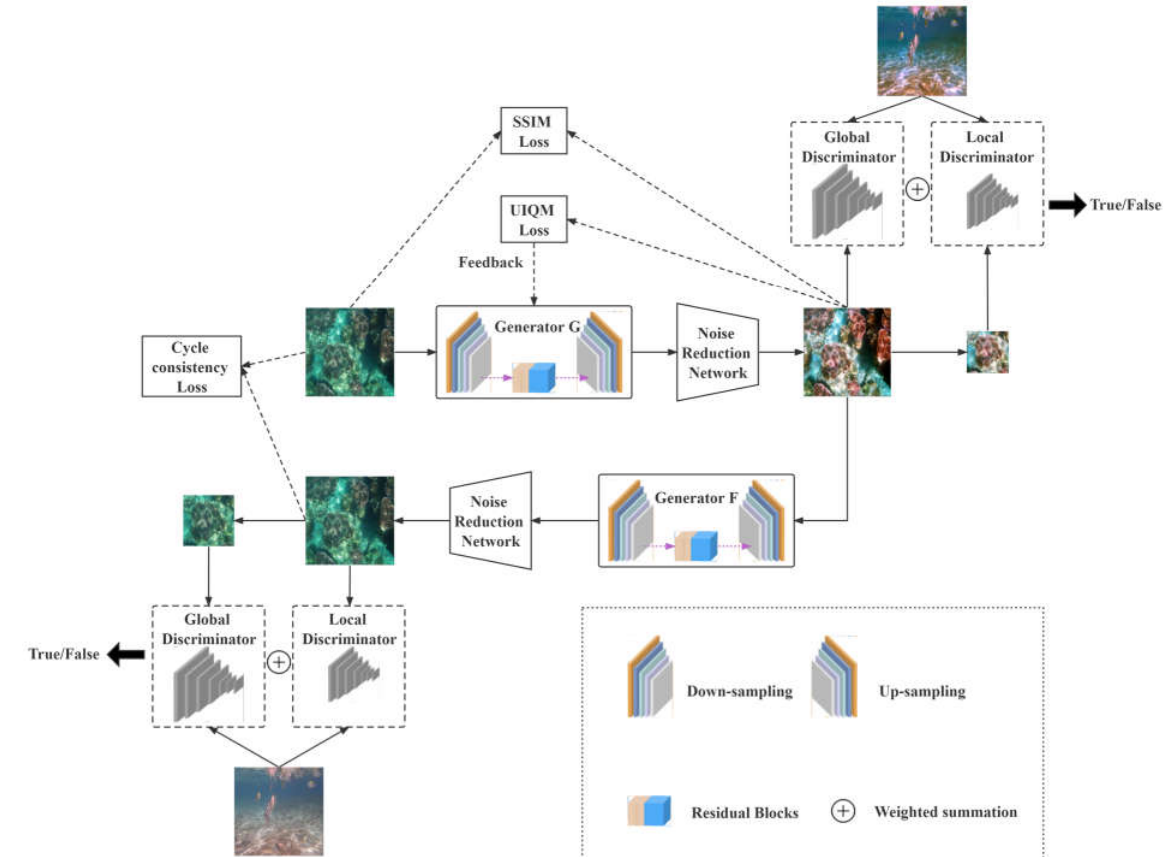
Figure 2. The overall framework of UMGAN.